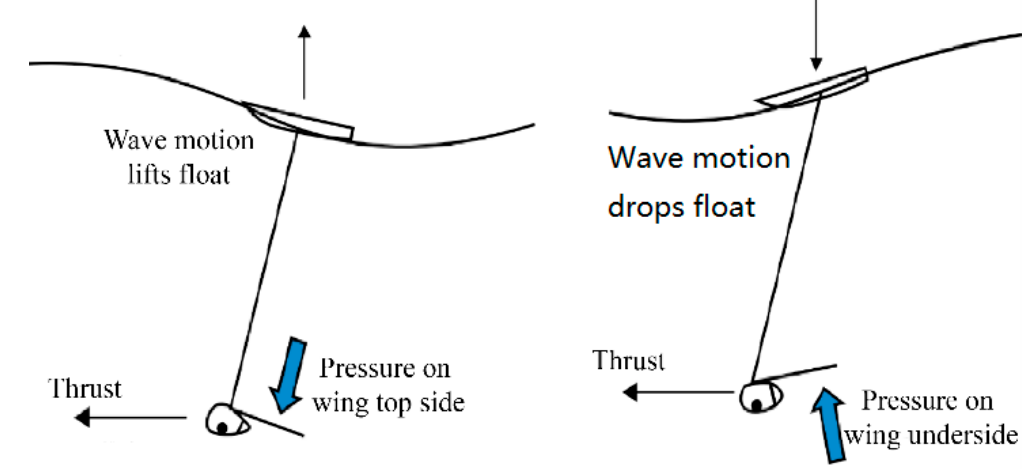
Figure 2. Wave Glider principles of operation.